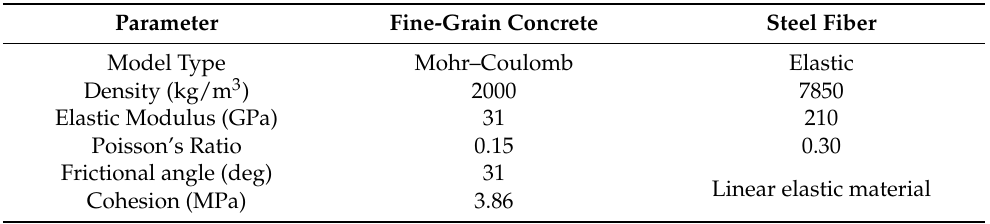
Table 1. Comparison of point cloud mesh to CAD model—cumulated